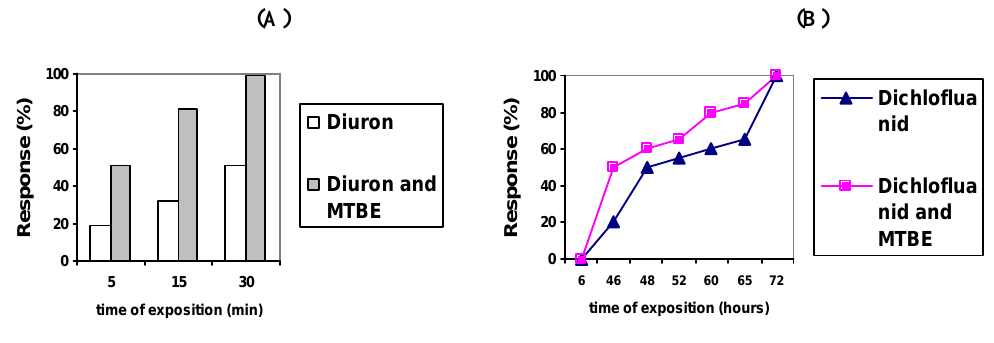
FIGURE 1. Increase in the toxic effect by the presence of MTBE in combination with Diuron and Dichlofluanid. (A) Analysis by V. fischeri toxicity assay. (B) Analysis by D. magna toxicity